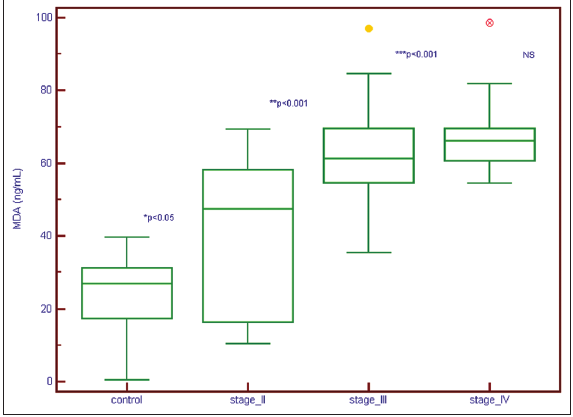
FIGURE 1. Serum malondialdehyde concentration in patients with different stages of CRC. The data are presented as median, with minimum–max- imum values. * p <0.05 - difference between control and stage II of CRC, ** p <0.001- difference between II and III stage of CRC, *** p <0.001 - differ- ence between II and IV stage of CRC. NS: No significance between III and IV stage of CRC. CRC: colorectal cancer, MDA: